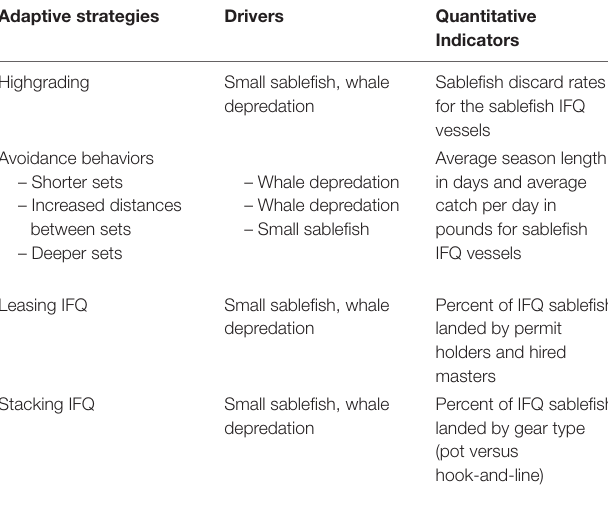
TABLE 1 | Adaptive strategies in response to small sablefish and whale